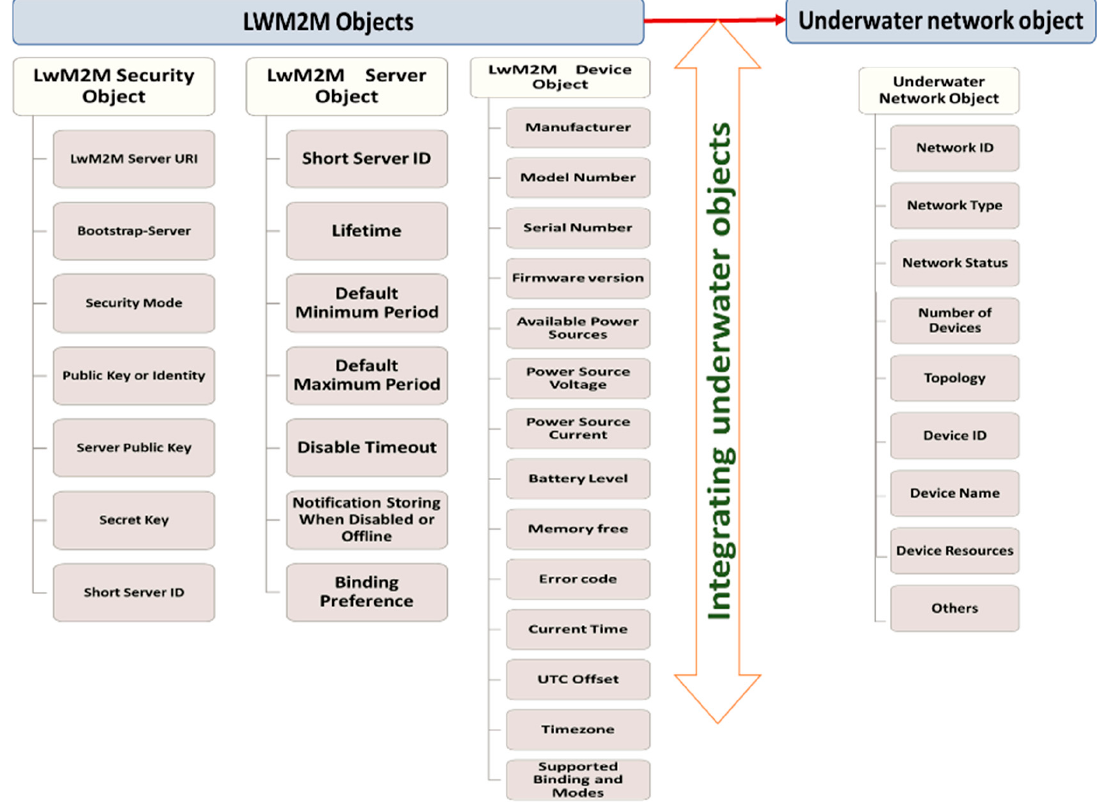
Figure 15. Defining underwater objects based on Open Mobile Alliance lightweight Machine to machine (OMA-LwM2M) in U-NMS.